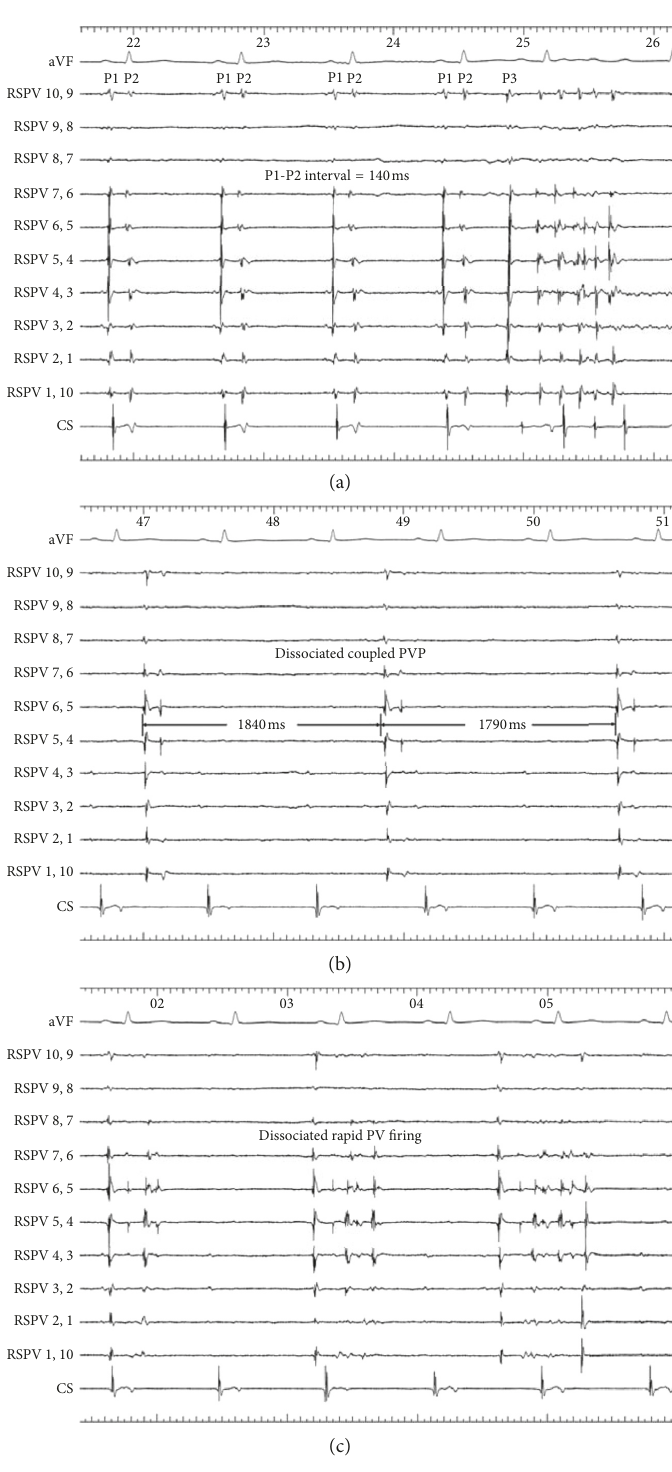
Figure 1: Tracings are from ECG lead aVF and intracardiac electrograms recorded from the electrode pairs of the circular mapping catheter positioned at the ostium of the right superior pulmonary vein (RSPV) and coronary sinus (CS). (a) There is a small atrial potential, followed closely by a pulmonary vein potential (PVP) ( P 1) and then by a second PVP ( P 2) during sinus rhythm. The concealed pulmonary vein bigeminy interval is 140 ms. Spontaneous rapid PV firing with the earliest potential P 3 conducts out of the vein and activates the atrium. (b) After ipsilateral right pulmonary veins isolation, dissociated coupled pulmonary vein potential was confined in the RSPV. (c) After ip- silateral right pulmonary veins isolation, rapid PV firing was confined in the RSPV with dissociation of atrial